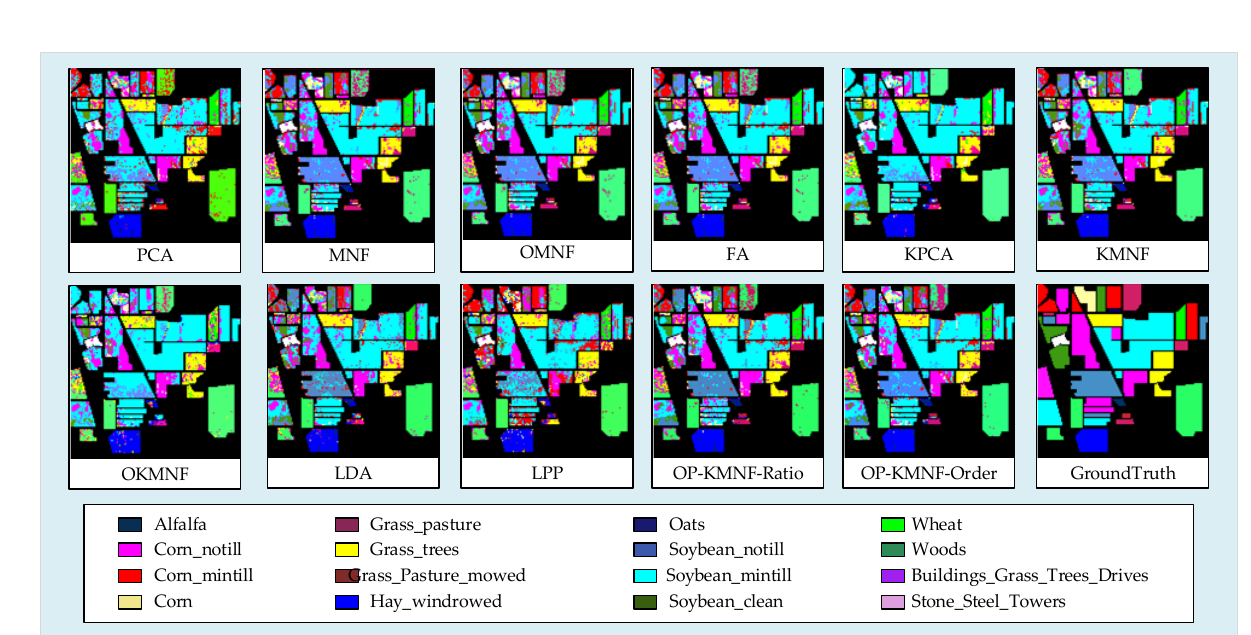
Figure 9. The SVM classification results of Indian Pines after different DR methods (number of features = 5).